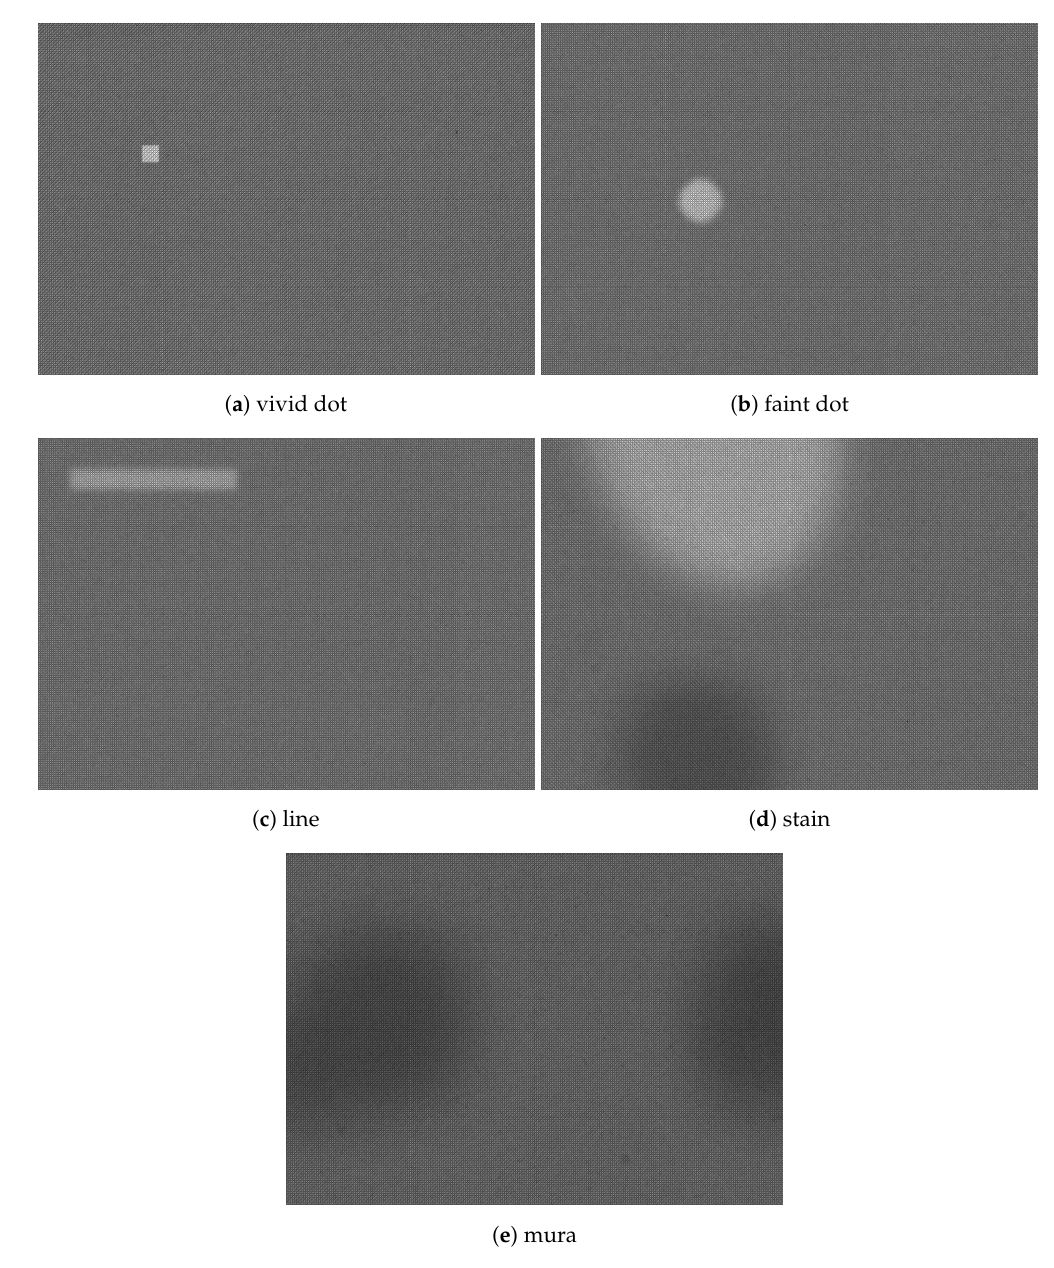
Figure 4. Examples of display panel